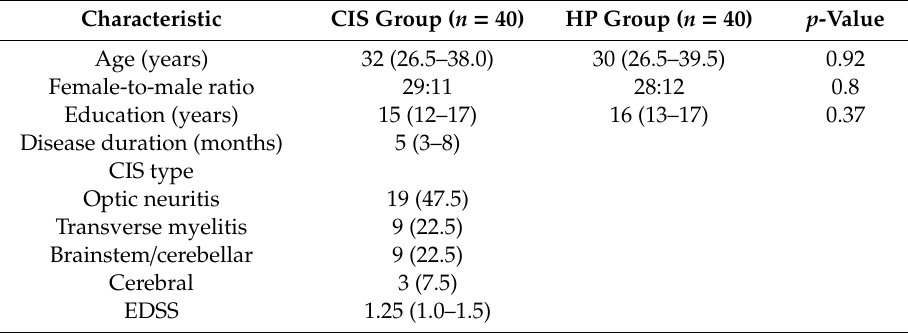
Table 1. Demographic and clinical characteristics of the study